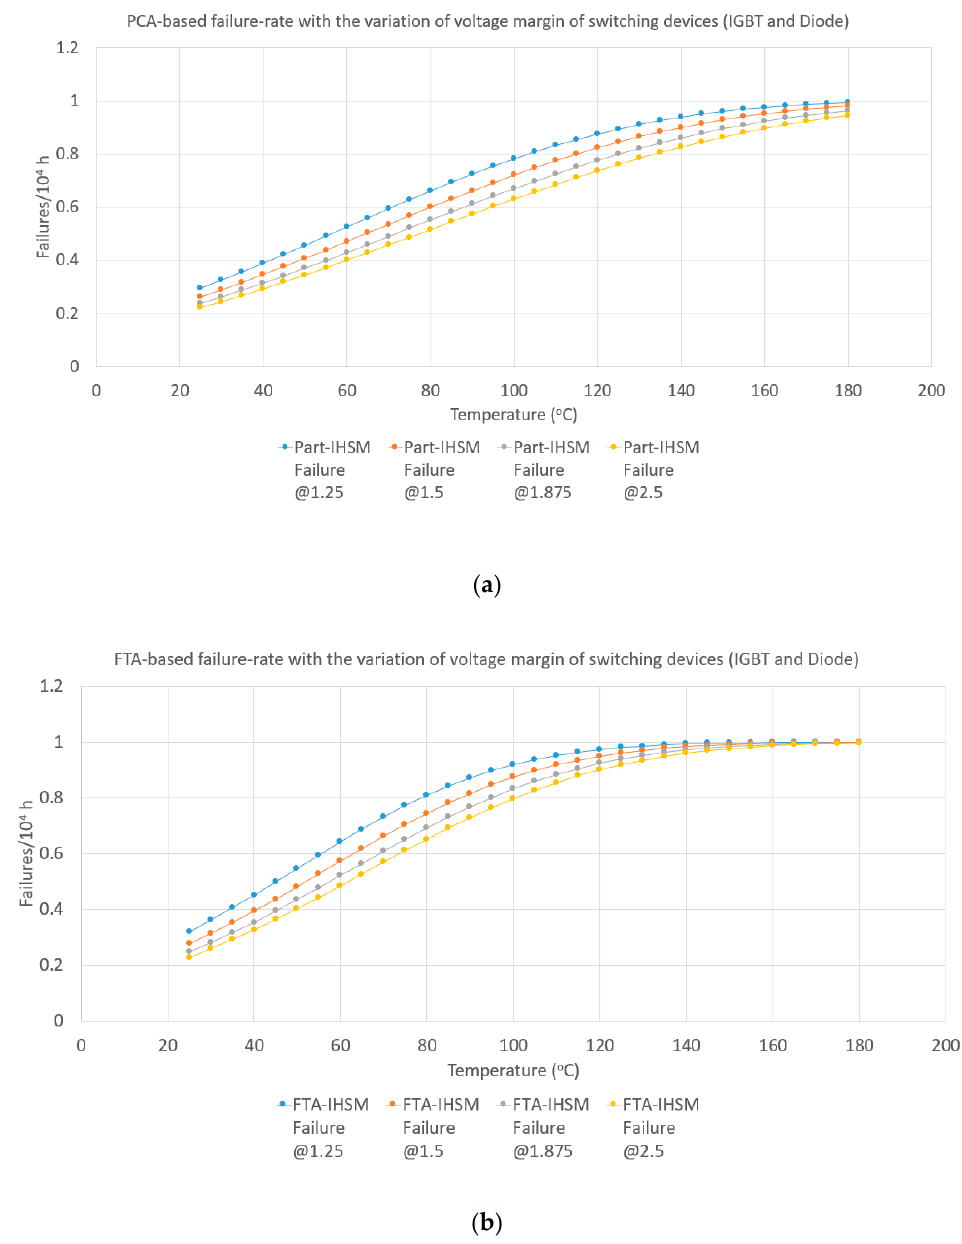
Figure 23. Failure rate according to the voltage margin of circuit components, ( a ) PCA-based, ( b ) FTA-based. Figure 24 analyzes the failure rate according to the working voltage margin of the capacitor of the IHSM. The switching device (IGBT and diode) is fixed at 1.875 times the voltage rating, and the failure rate is analyzed when the capacitor working voltage margin is changed to 1.04, 1.08, 1.15, 1.25, and 2.5 times. Changing the capacitor working voltage margin with the voltage margin of 1.875 times for the IGBT and diode has little effect on the overall failure rate of the IHSM. Therefore, if capacitors are designed to have a 1.15 × working voltage margin, they are not significantly affected in terms of failure rates and can change the working voltage margin of capacitors considering the average applied voltage, cost, size, and